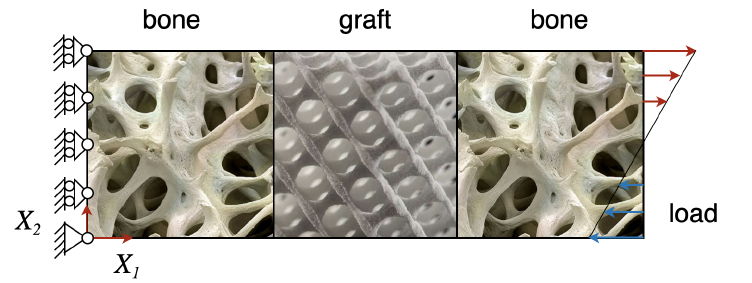
Figure 1. Schematic representation of the system under study. It is constituted by two pieces of bone tissues joined by a graft made of a bio-resorbable material, that is the BGB